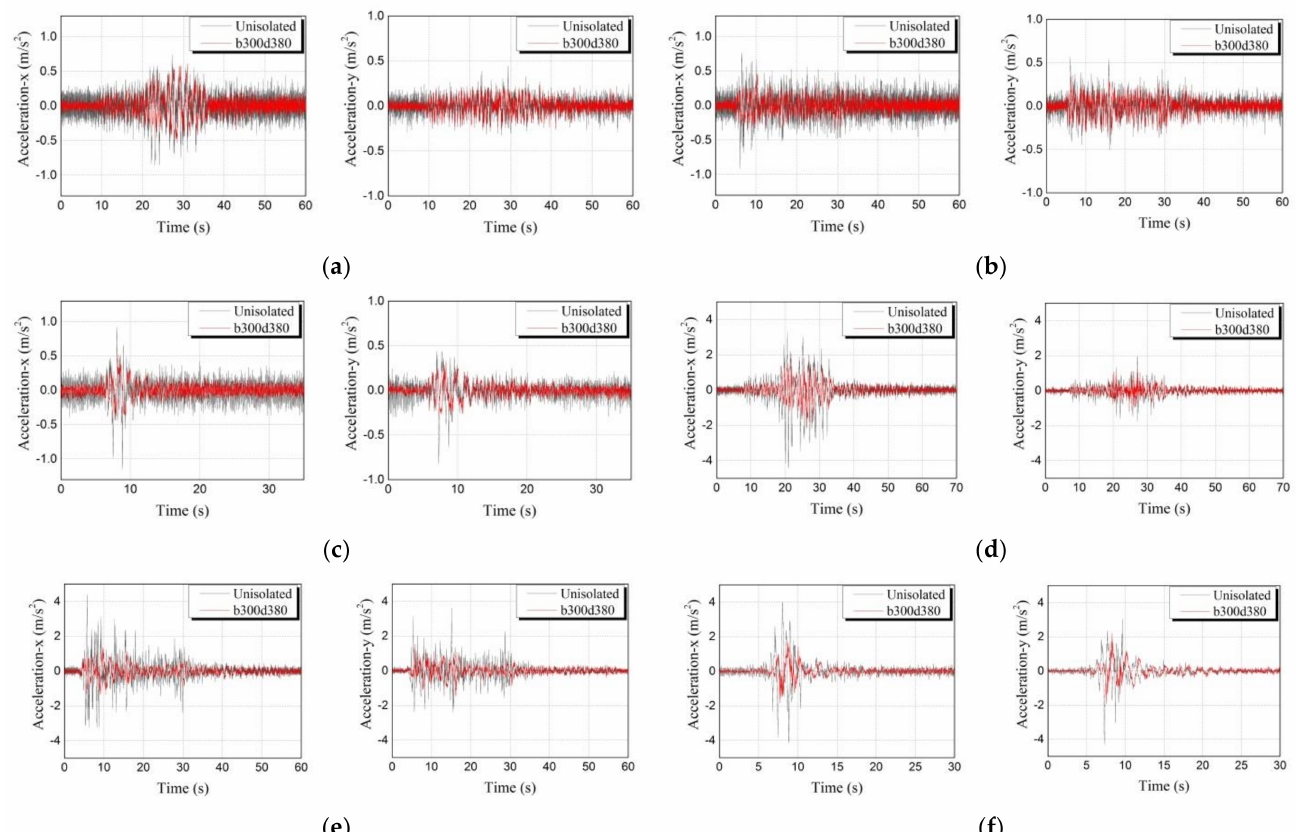
Figure 23. Acceleration comparisons between the equipment with b300d380 bearing and without isolation subjected to three intermediate-frequency ground motions with PGA of 0.7 m/s 2 and 4 m/s 2 . ( a ) Acceleration comparisons under ChiChi-TCU084 ground motion when PGA = 0.7 m/s 2 . ( b ) Acceleration comparisons under ELcentro-BCJ ground motion when PGA = 0.7 m/s 2 . ( c ) Acceler- ation comparisons under Kobe ground motion when PGA = 0.7 m/s 2 . ( d ) Acceleration comparisons under ChiChi-TCU084 ground motion when PGA = 4 m/s 2 . ( e ) Acceleration comparisons under ELcentro-BCJ ground motion when PGA = 4 m/s 2 . ( f ) Acceleration comparisons under Kobe ground motion when PGA = 4 m/s 2